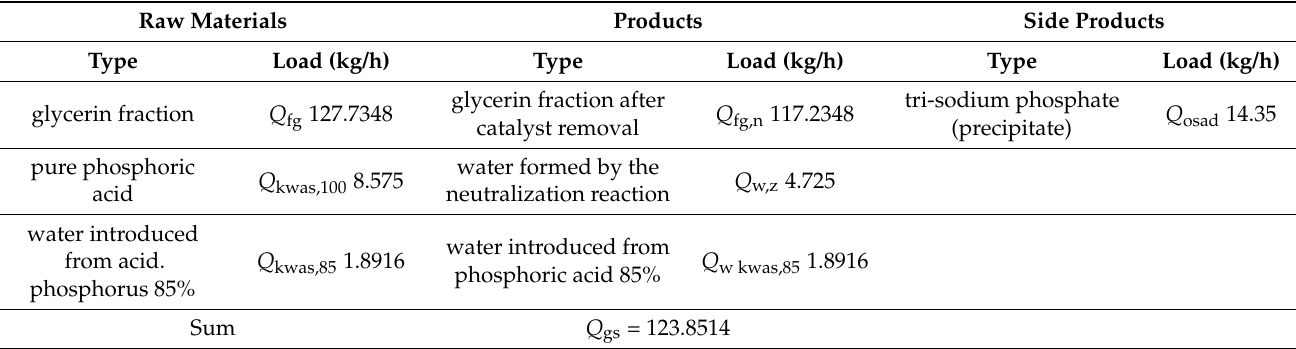
Table 7. Material balance of raw materials, products, and by-products after the catalyst removal step from the glycerin fraction. Raw Materials